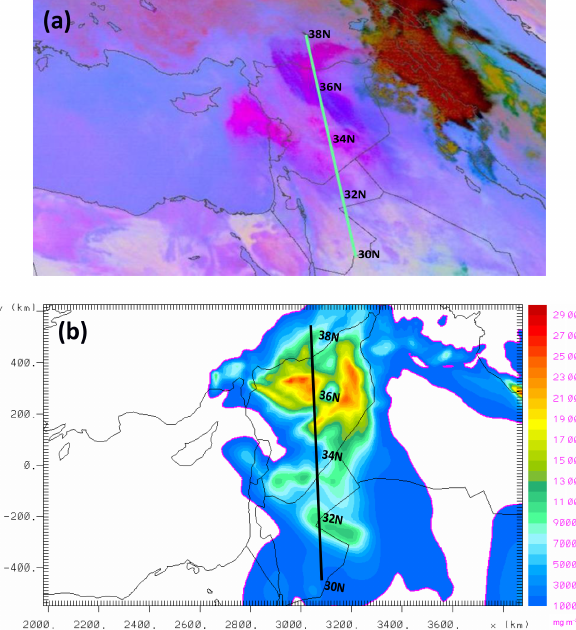
Figure 9. (a) MSG-SEVIRI RGB map and CALIPSO overflight (green line); (b) model dust load (mgm − 2 ); (c) CALIPSO dust mass concentration (µgm − 3 ); and (d) model dust mass concen- tration on 6 September 2015, 23:33UTC. Due to the severity of the event, the CALIPSO signal is totally attenuated below ∼ 1kma.s.l. in the area between 35 and 37 ◦ N (dark blue